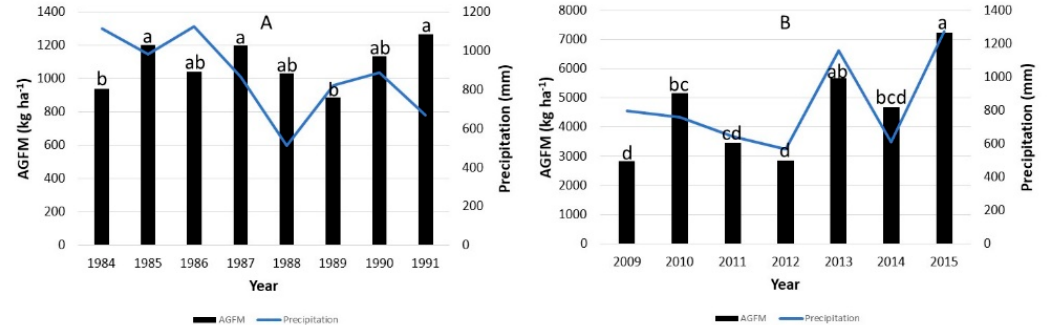
Figure 2. September (peak) above-ground forage mass by year for sites KP000a ( A ) and GRL ( B ). Above-ground grassland or forage mass (AGFM) levels within sites not connected by the same letter are statistically di ff erent. Annual rainfall is shown as the blue line.